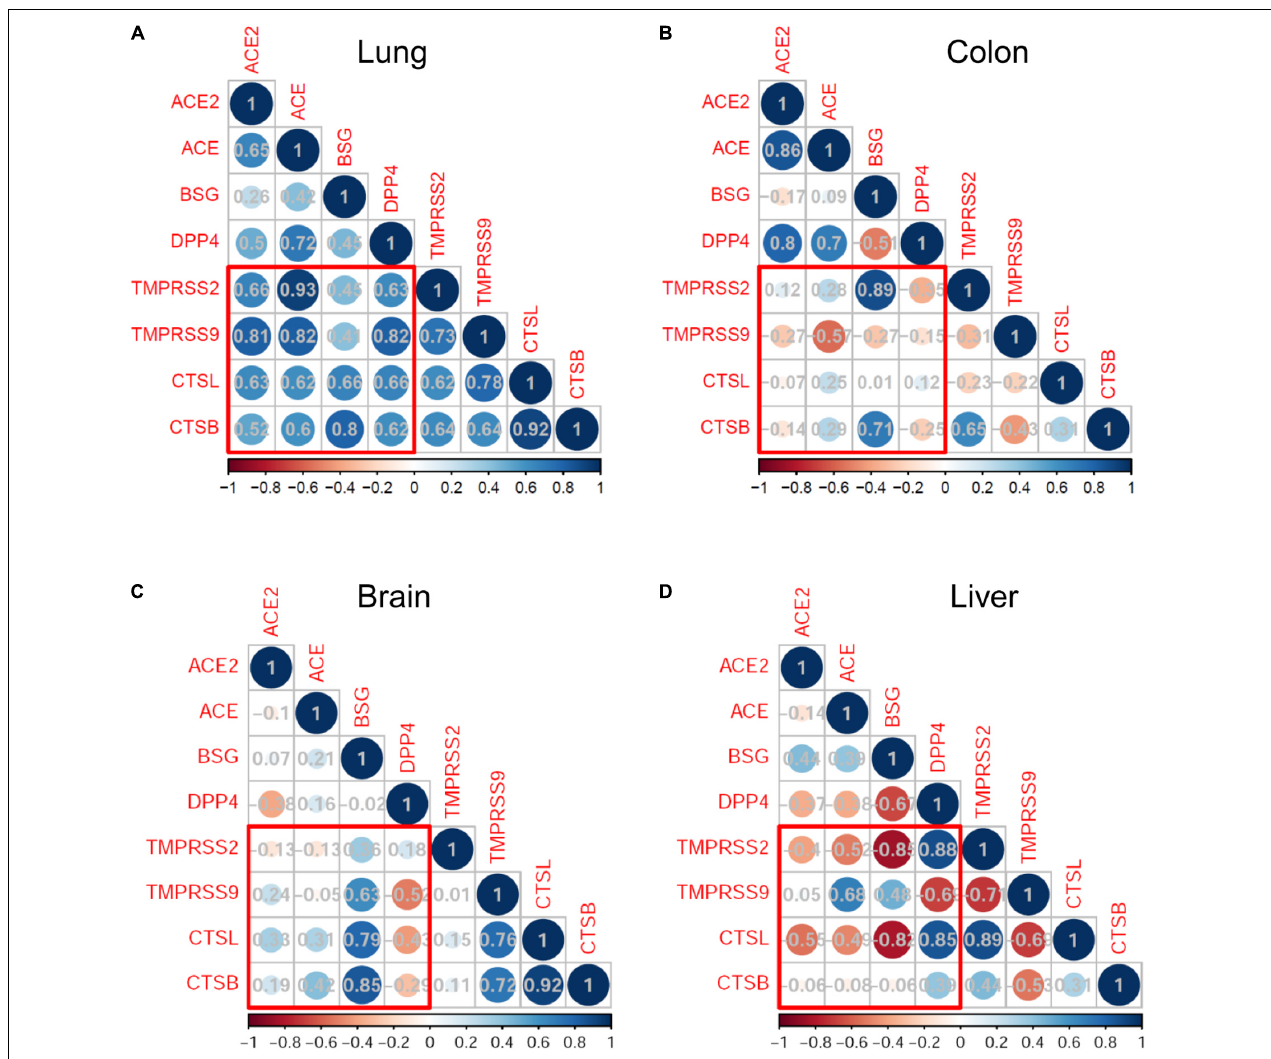
FIGURE 3 | Correlation analysis of severe acute respiratory syndrome coronavirus 2 (SARS-CoV-2) infection mediators in monkey development. Correlation map represents the Pearson correlation coefficient between each pair of genes. The bottom bars indicate the color legends of the Pearson correlation coefficient r . Results are shown in the lungs (A) , colon (B) , brain (C) , and liver (D)